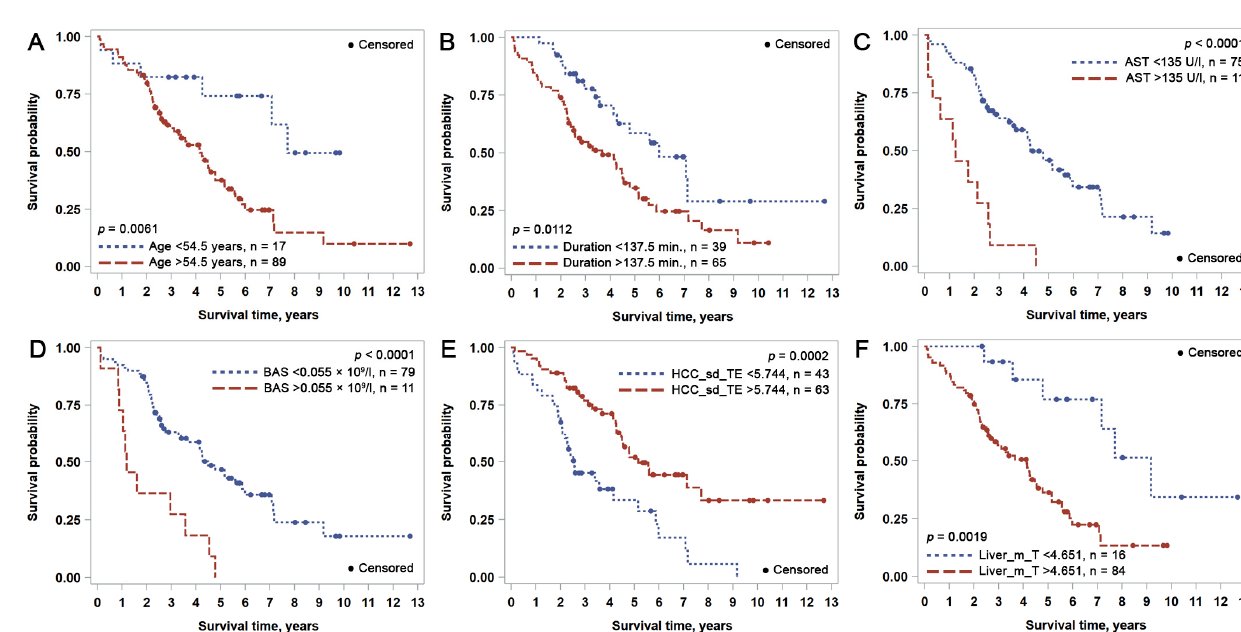
Figure 2. Kaplan-Meier overall survival (OS) plots for independent prognostic indicators identified